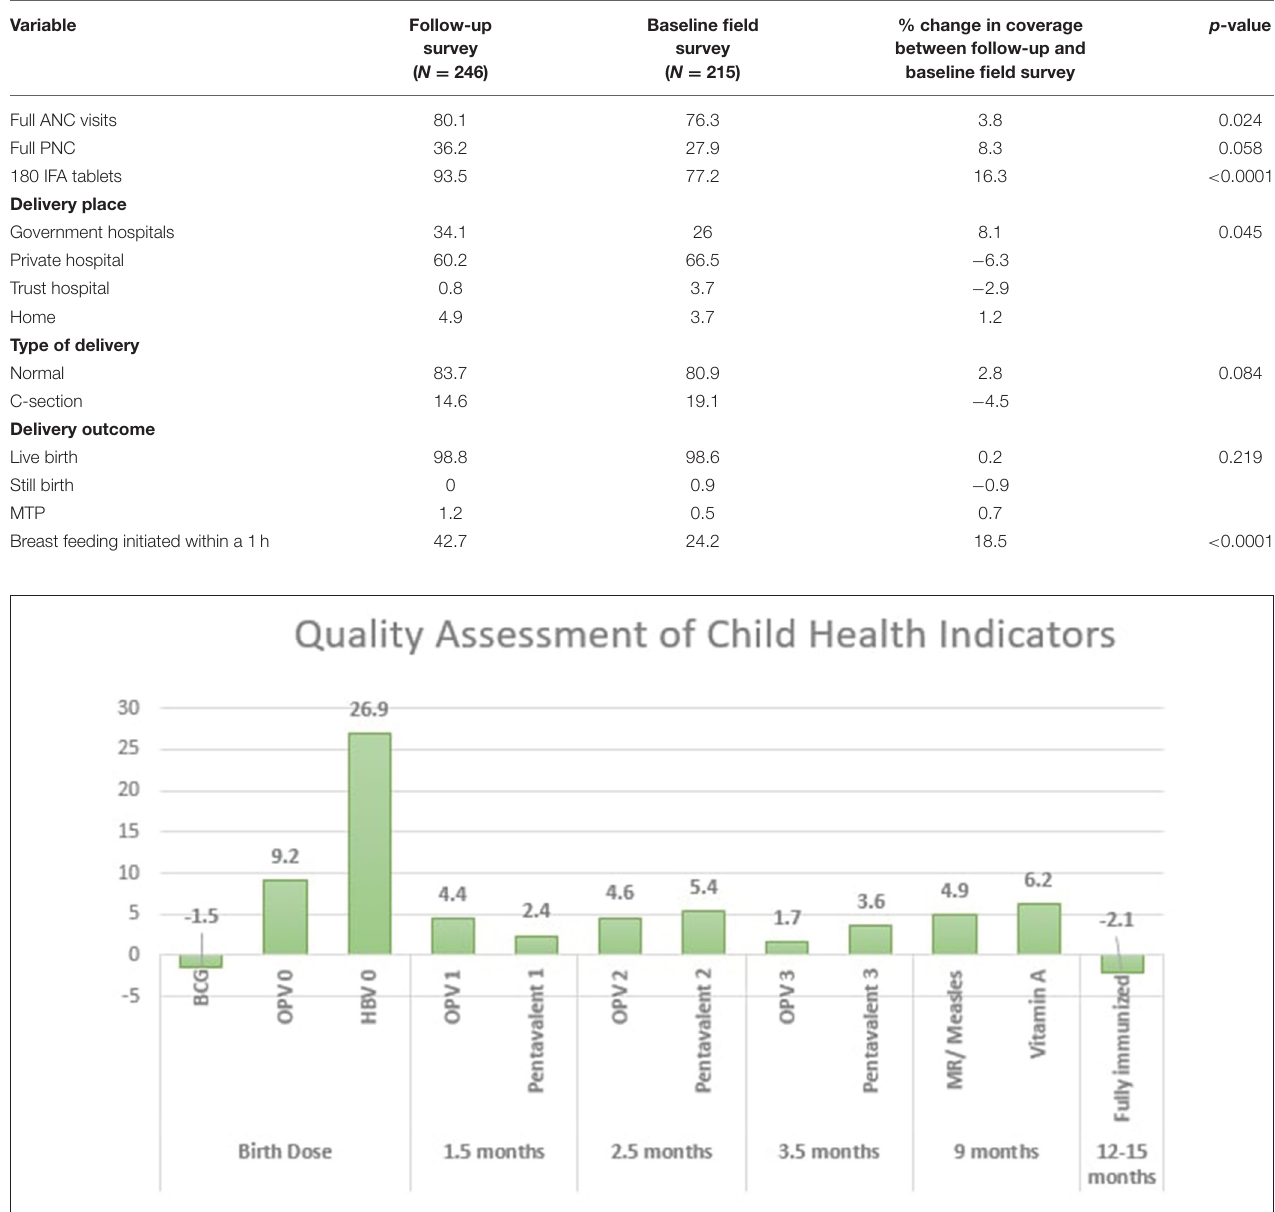
FIGURE 3 | Quality assessment of child health